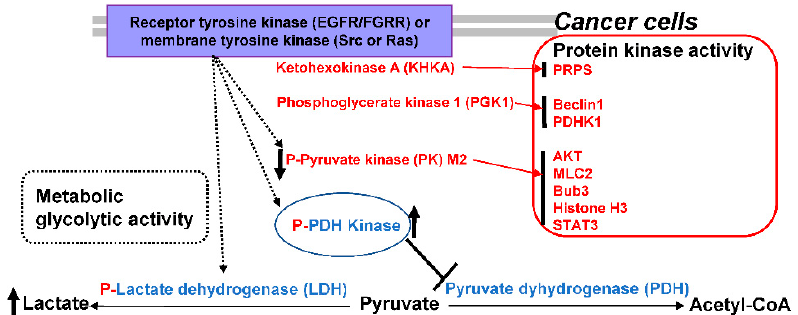
Figure 2. Protein kinase activities of metabolic enzymes PKM2, PGK1, HK and keto-HK-A in aerobic glycolysis.